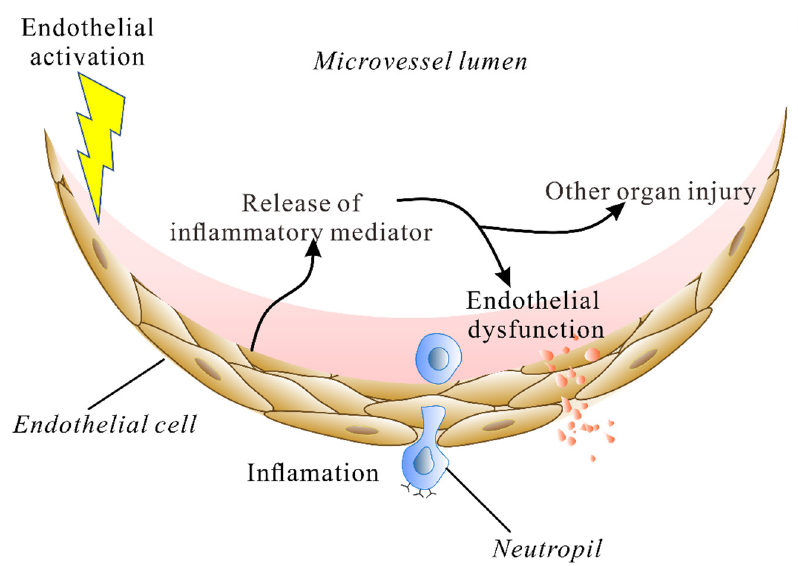
Figure 1. The endothelium is both a sensor of stimulation and a mediator of organ injury in ALI. The endothelium can sense intravascular stimulation and the activation of endothelium results in an increased activation of pro-inflammation transcriptions and release of inflammatory mediators, which leads to dysfunction of endothelium and other organ injury.